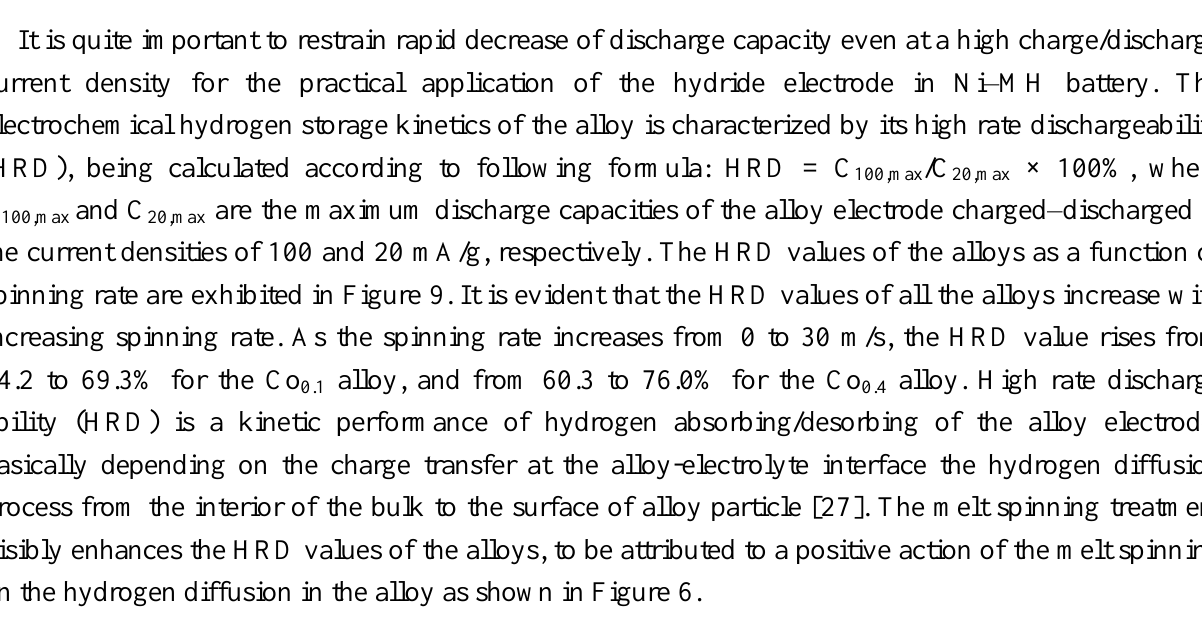
Figure 9. Evolution of the high rate discharge ability (HRD) of the alloys with the spinning